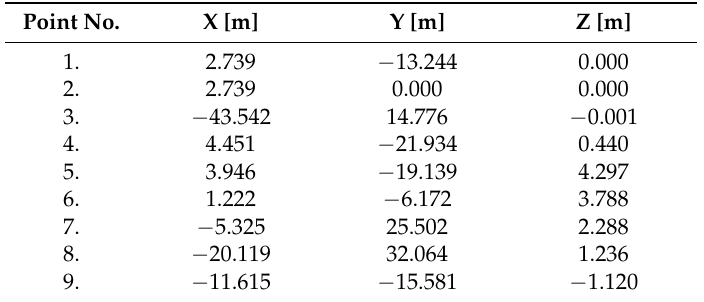
Table 4. Points from primary system—Table 2—translated to the centroid—point no. 2. Point No.